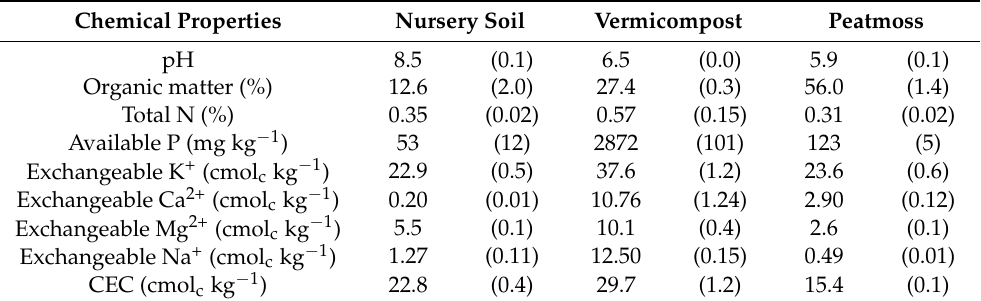
Table 1. Chemical properties of the nursery soil, vermicompost, and peatmoss used in the study. Chemical